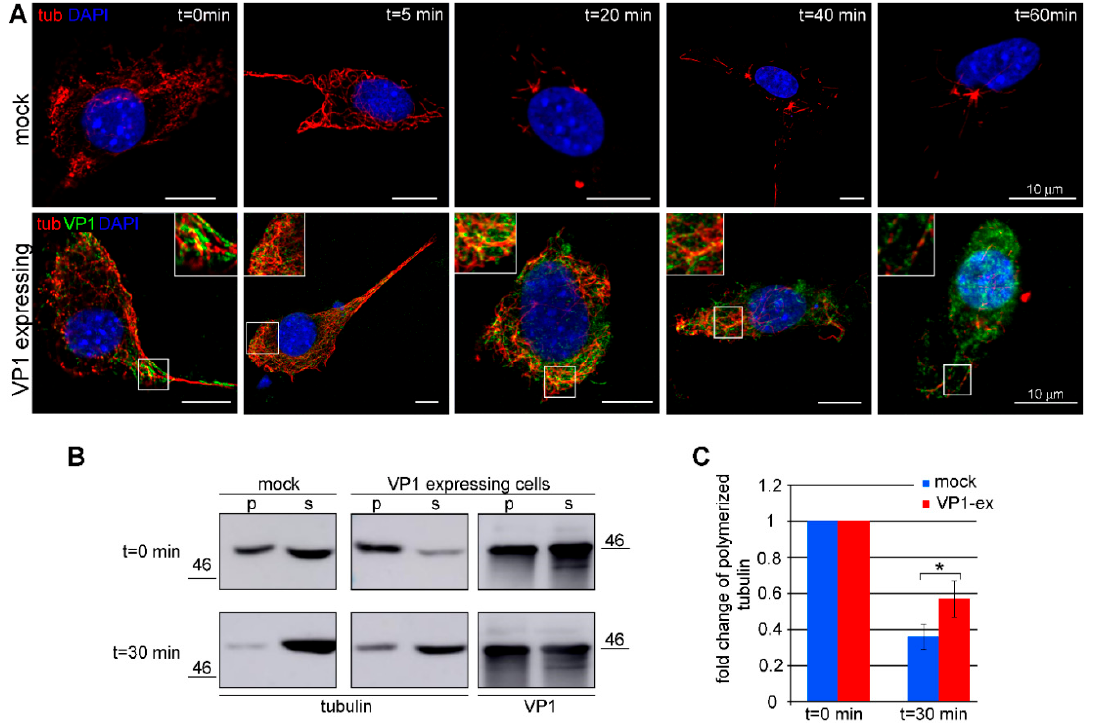
Figure 5. VP1 protects microtubules from nocodazole induced depolymerization. WOP cells were transfected with plasmids expressing VP1 and 24 hpt cells were treated with nocodazole (4 µM) for the indicated times. ( A ) After the treatment, soluble tubulin was washed out, the cells were fixed, and polymerized tubulin (tub; red) and VP1 (green) were stained by specific antibodies. Shown are the selected confocal sections. Enlarged details of the cells are presented in insets. Bar: 10 µ m. ( B ) After the treatment, cells were fractionated into a soluble tubulin fraction (s) and polymerized tubulin fraction (p). Equal amounts of the fractions were resolved via SDS / PAGE, immunoblotted, and tubulin and VP1 were stained with specific antibodies. ( C ) A graphic illustration of a densitometry analysis of the digital images of Western blots from three independent experiments. The fold change in polymerized tubulin relative to the mock-treated cells ( t = 0 min) is shown. +/ − SD; * p < 0.05 determined by Student’s t test.